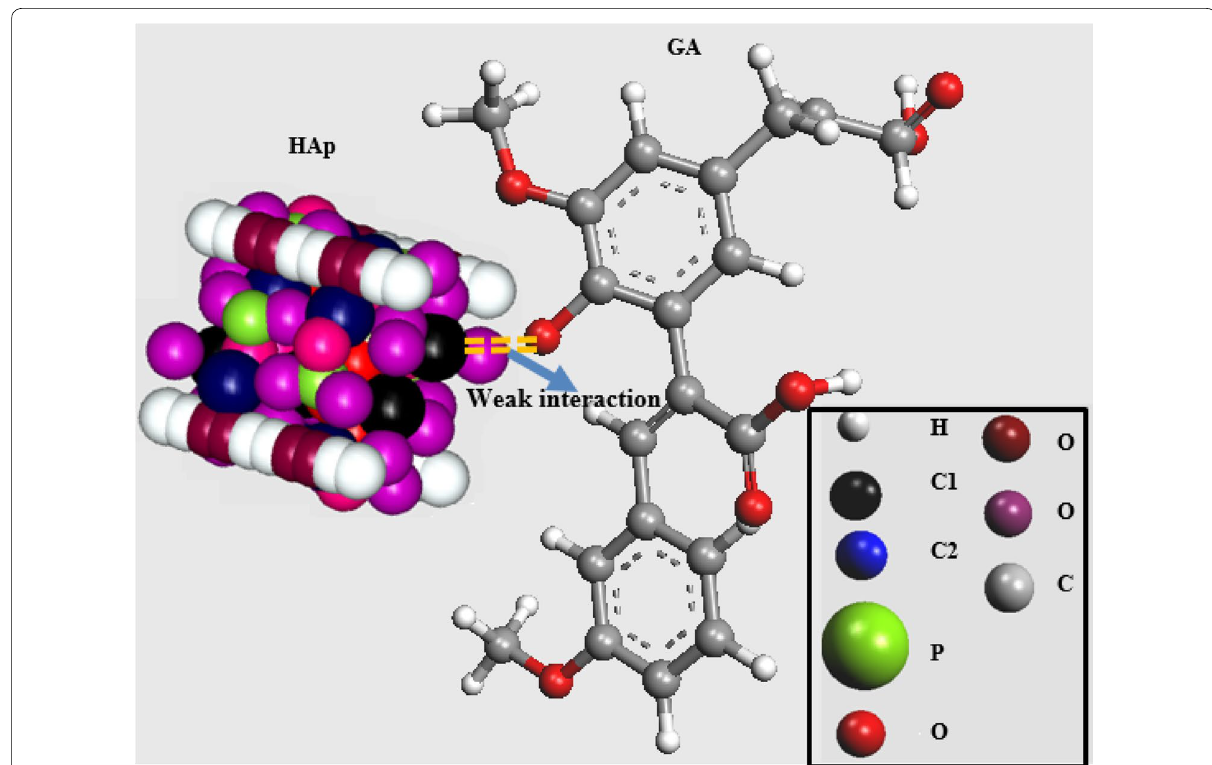
Fig. 4 A 3D schematic model of the weak interaction between the CO groups in GA and the